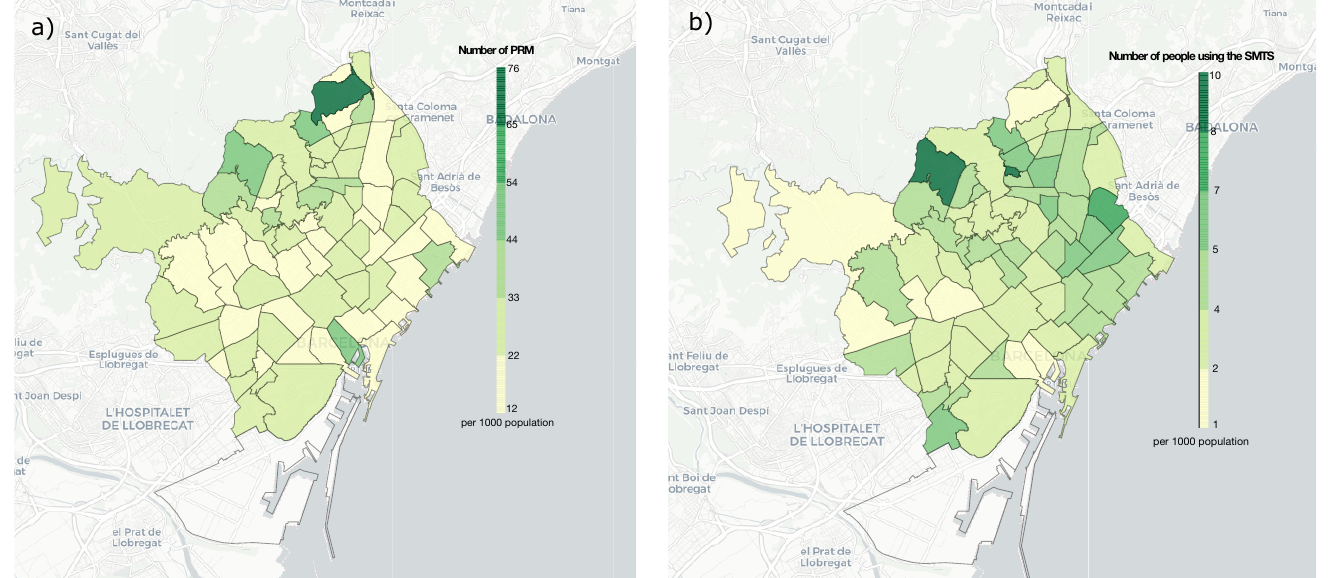
Figure 3. ( a ) Density of the PRM residing in each neighbourhood of the city of Barcelona (per 1000 inhabitants); ( b ) Density of the of SMTS users residing in each neighbourhood of the city of